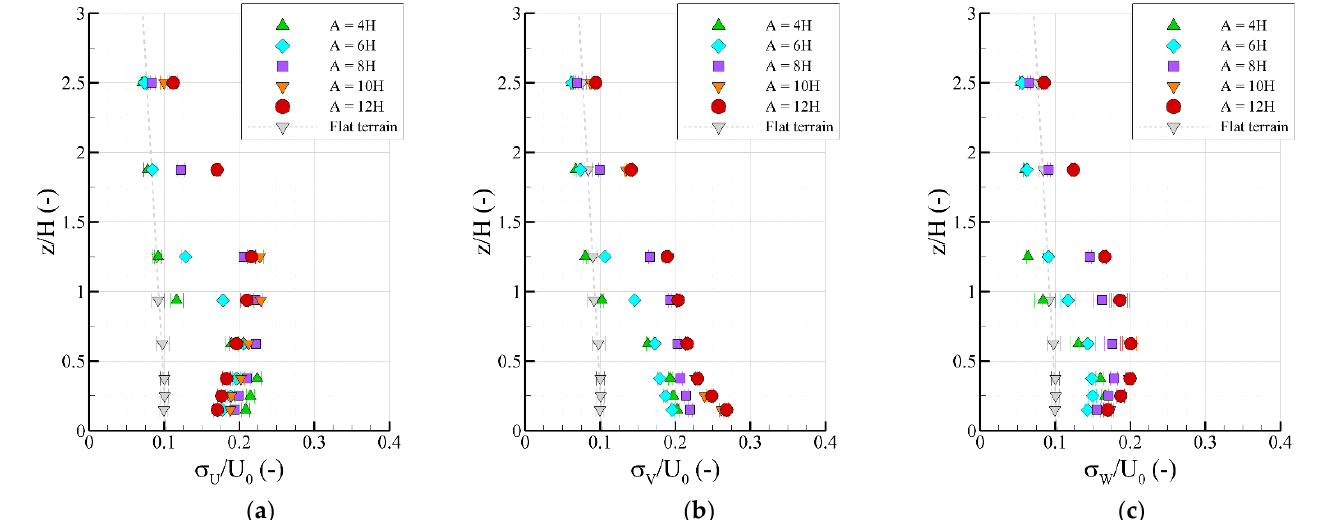
Figure 7. Vertical profiles of the normalized longitudinal ( a ), lateral ( b ), and vertical ( c ) velocity fluctuations above the crests of the second ridges. Table 3. Average ratios of longitudinal to lateral and vertical turbulence from z/H ≤ 1.25 above the crests of the second ridges.